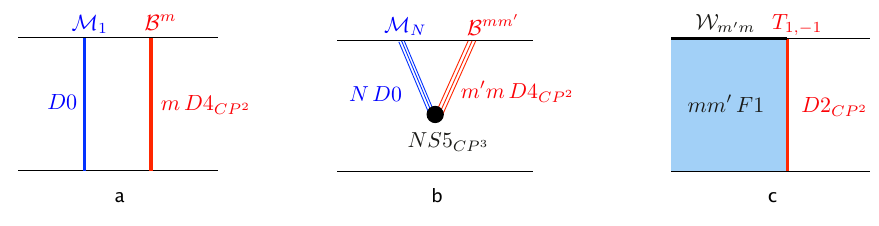
Figure 6 . AdS 4 dual of (U( N ) k (cid:2) U( N ) (b) Chiral ring relation. (c) k = m 0 m fundamental Wilson lines screened by an anti-symmetric